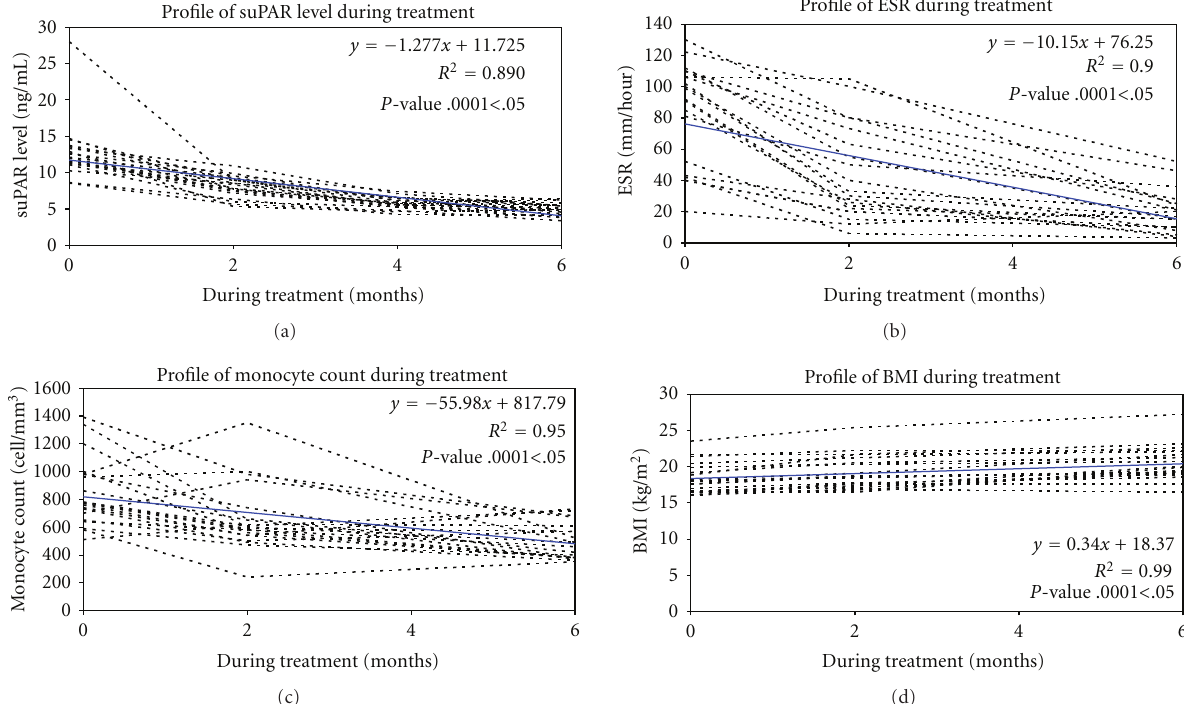
Figure 1: (a) Serum levels of soluble urokinase receptor (suPAR), (b) sedimentation rate of erythrocytes (ESR), (c) monocyte count (d) Body Mass Index (BMI) in 20 TB patient before (0), during (2 and 4 months), and after (6 months) completion of anti-TB treatment. Individual profile (dotted line) and median (thick line) levels are